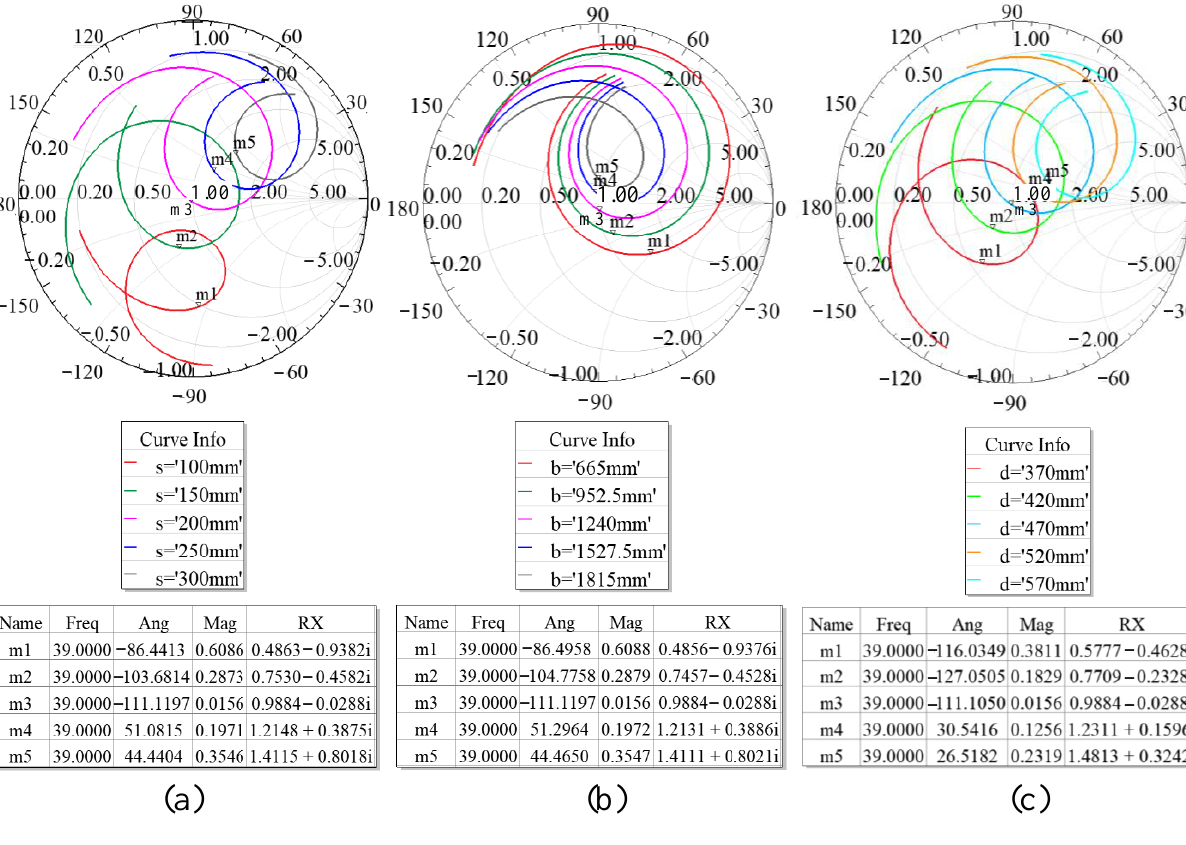
Figure 2. The simulation results of the designed turnstile antenna with varying parameters ( a ) s , ( b ) b and ( c ) d